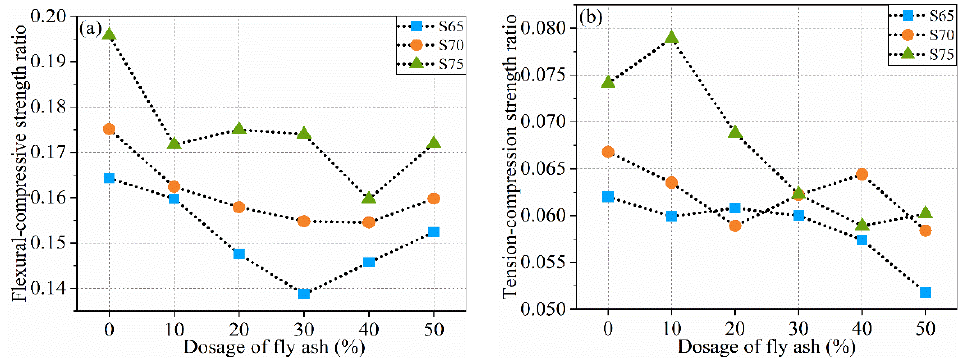
Figure 8. Flexural and the tension compression ratios of specimens ( a ) FCR; ( b ) TCR.